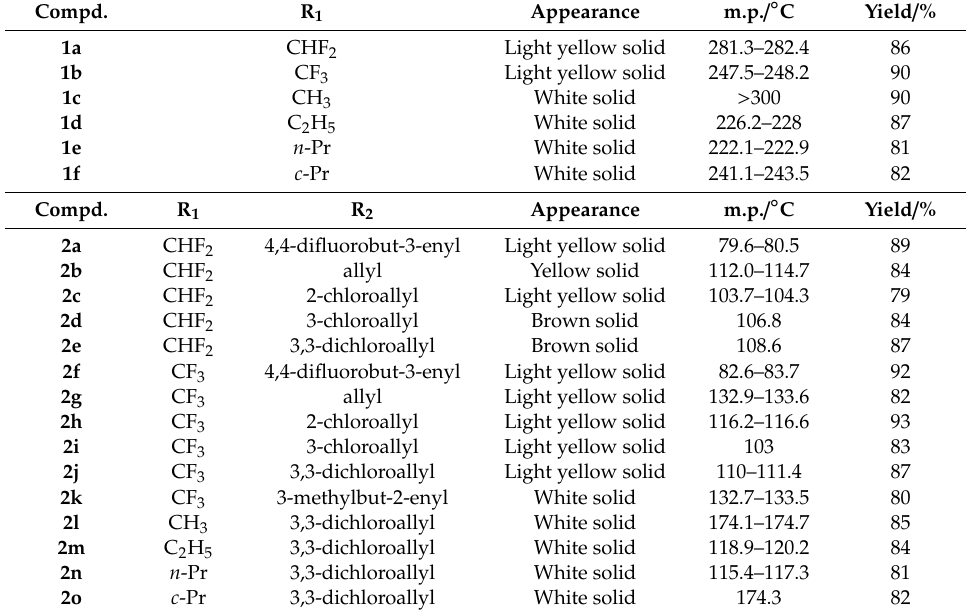
Table 1. The physical properties of the intermediates 1a – 1f and 2a – 2o. Compd.